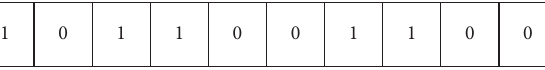
Figure 1: Structure of a sample chromosome.